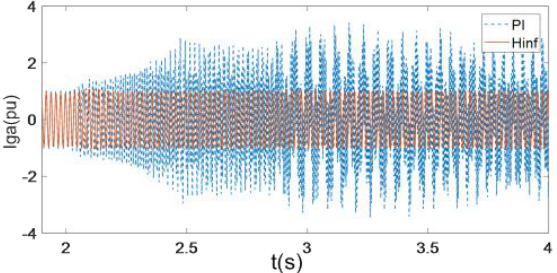
Figure 28. Current i ga at different impedance of the transmission line in PI.